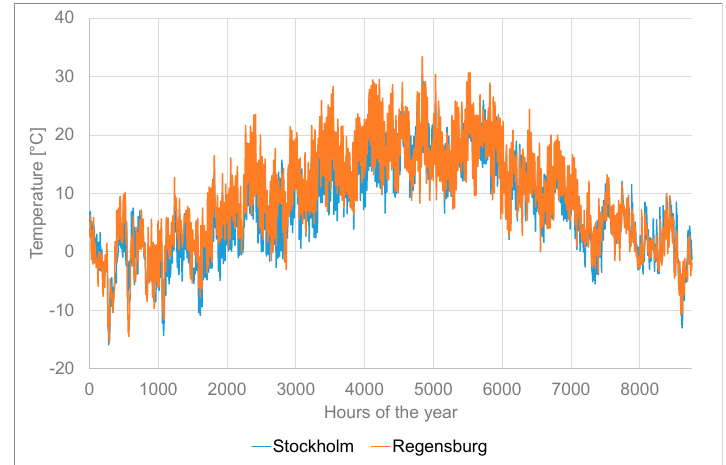
Figure 5. Hourly ambient temperature evolution for a reference year in Stockholm (Sweden) and Regensburg (Germany), evaluated from the Meteonorm 7.0 database .